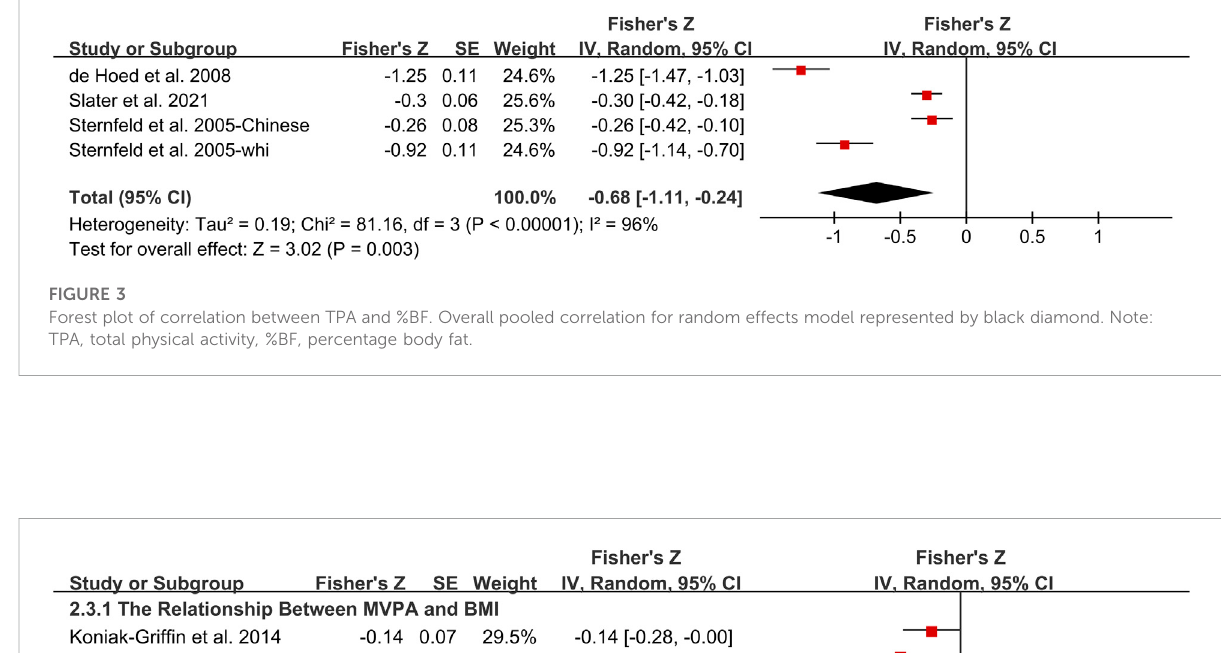
the strongest associations noted for African American women TPA and %BF ( r = − 0.59; 95% CI: − 1.11, − 0.24; p = 0.003, n = 4;